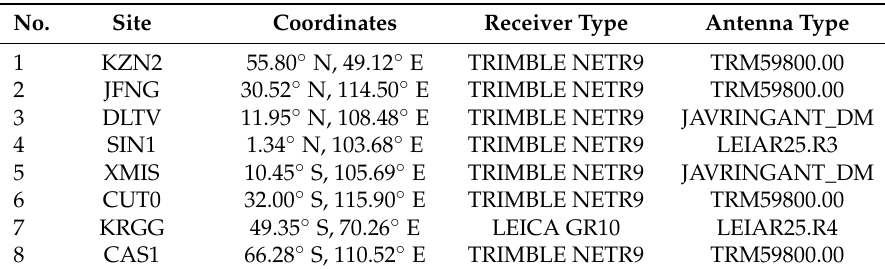
Table 2. Information about all